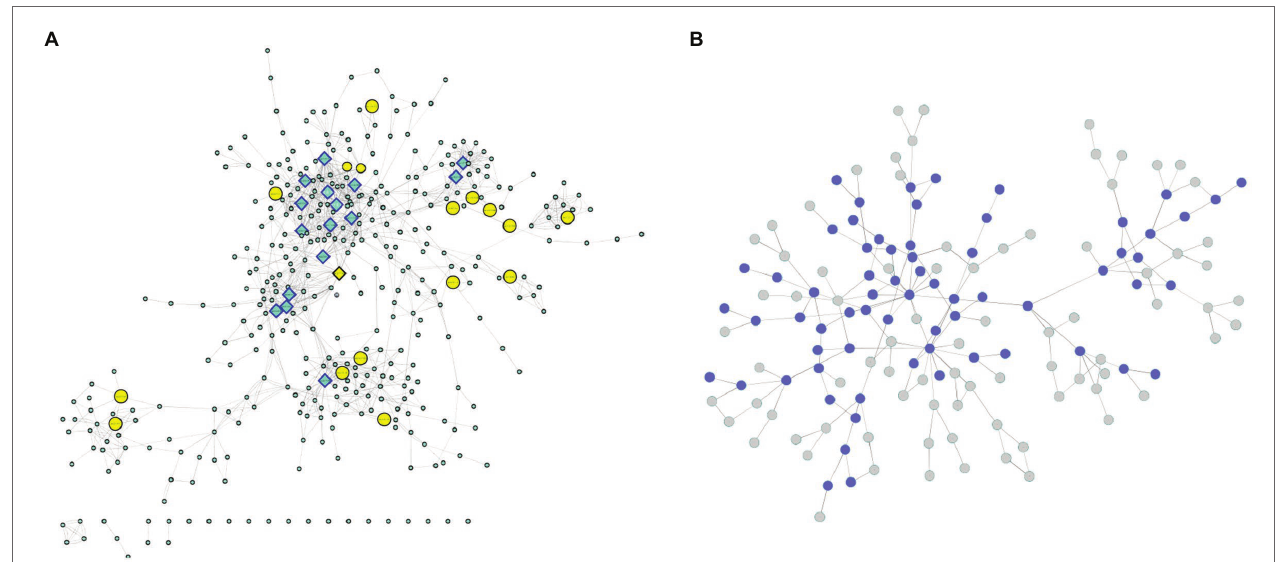
FIGURE 7 | (A) Enzyme network. The yellow nodes represent the enzymes discovered in the coexpression modules, and the rectangular nodes indicate the enzymes with the highest centrality values. (B) Communities. The blue nodes are represented by communities containing enzymes discovered in the coexpression